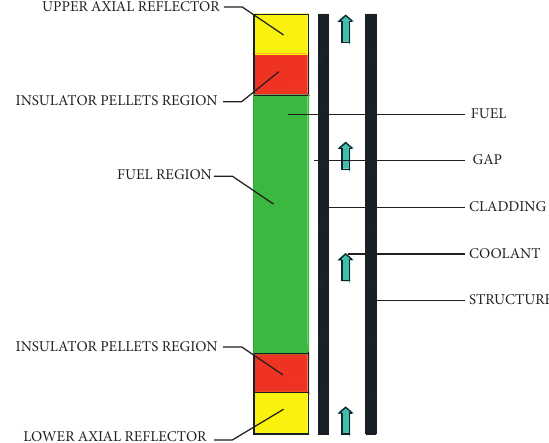
Figure 9: Thermal-hydraulics model of driver fuel